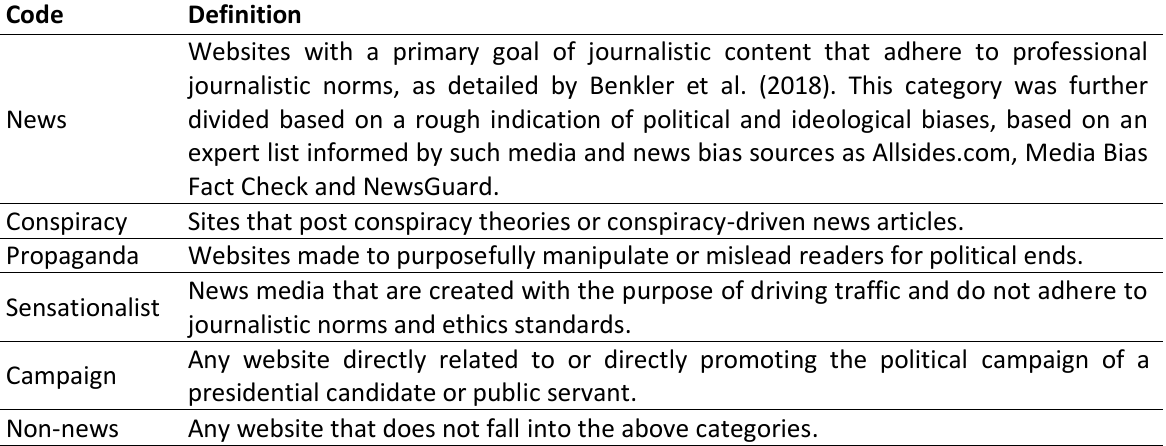
Table B. Definitions for “junk news” coding schema. Adapted from the analysis of Benkler et. al.